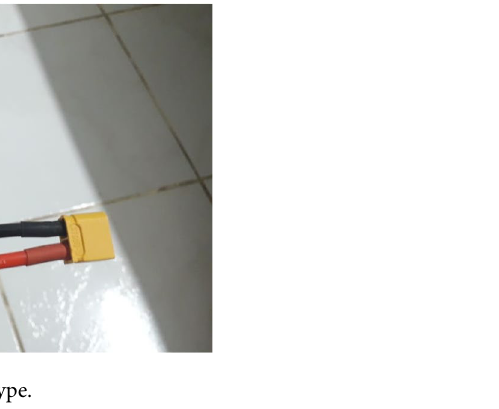
Figure 20. Autopilot embarked in the